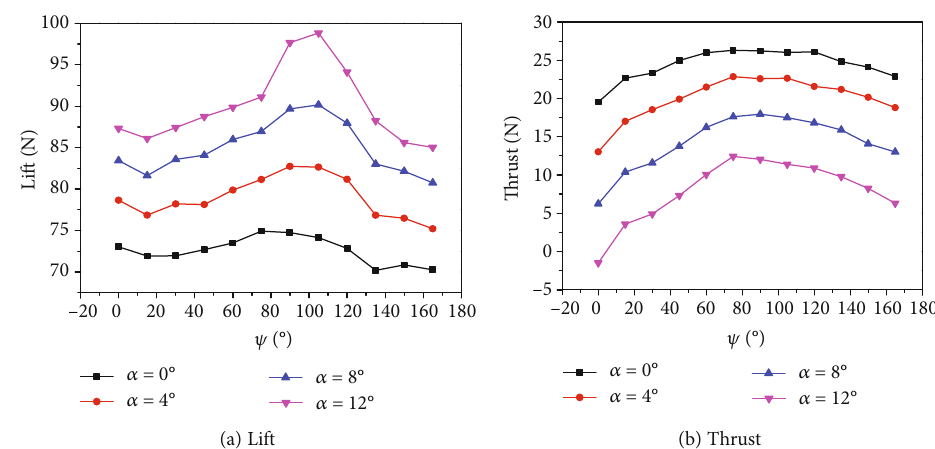
Figure 11: The variation curve of installation angle of a double leading edge winglet with angle of attack ( v = 12 m/s).